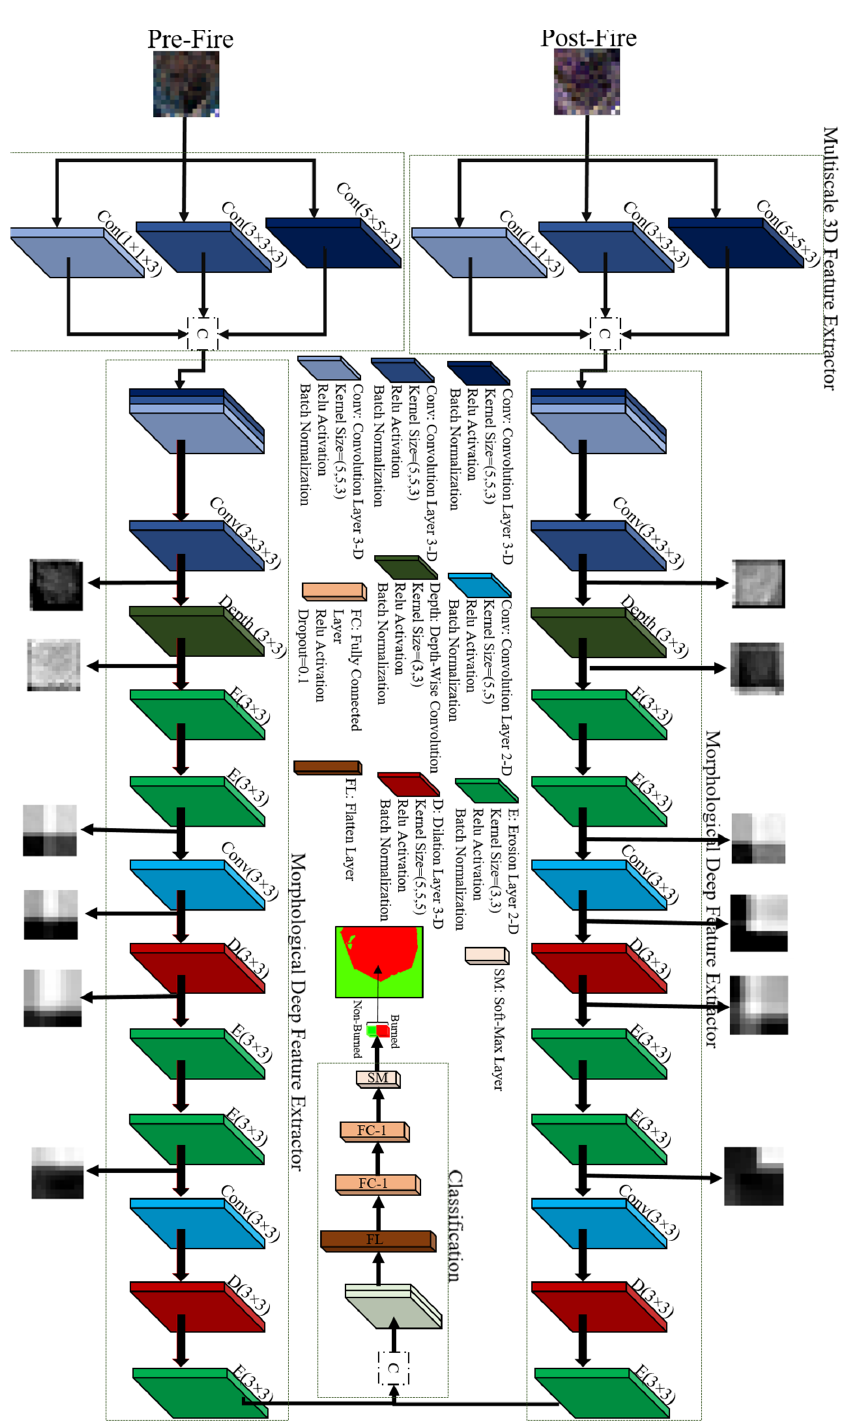
the proposed DSMNN-Net for random pixels. The first layers show the shallow features, while the middle layers focus on the general structure around the central pixel.